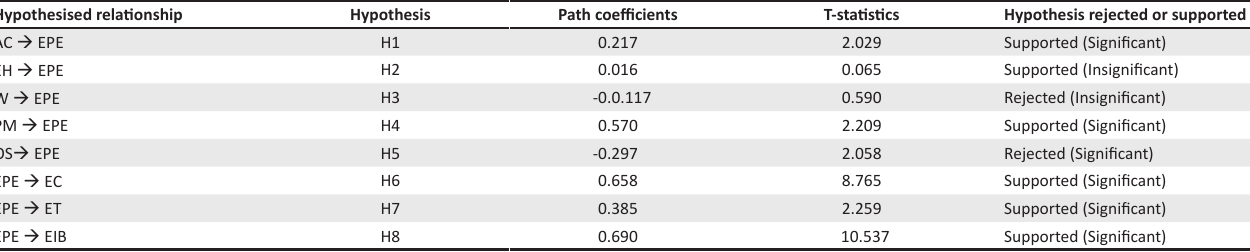
TABLE 3: Results of structural equation model analysis. Hypothesised